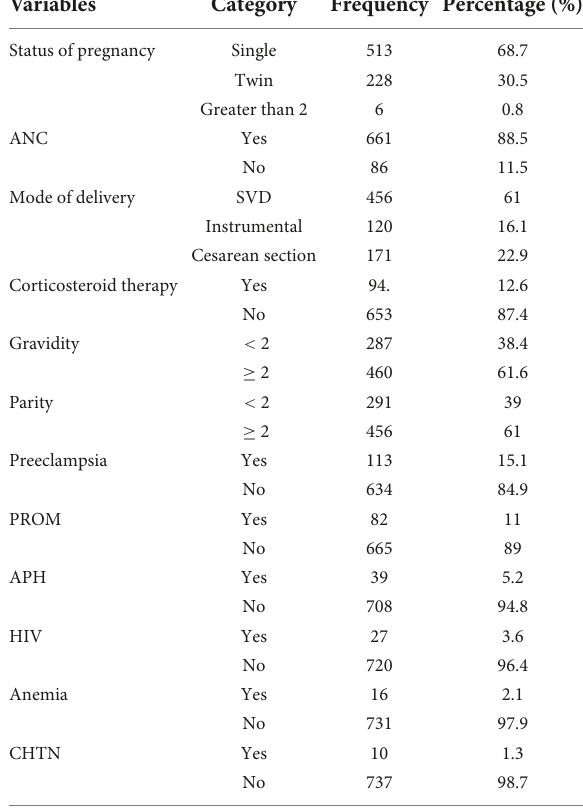
TABLE 2 Maternal obstetric characteristics among low birth weight (LBW) neonates admitted to the NICU of FHCSH, Ethiopia from